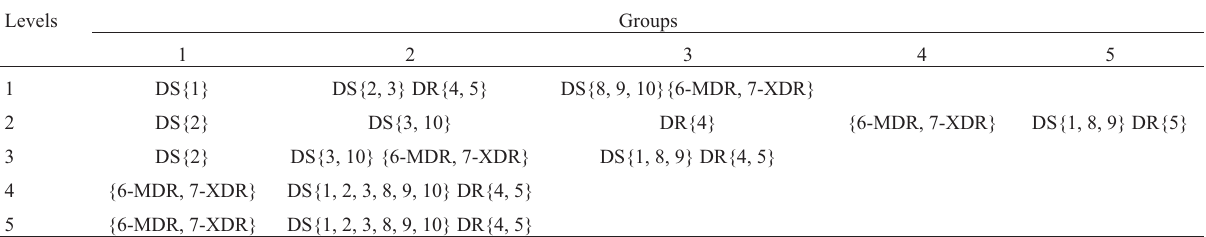
Table 3 - Formation of the groups at each level of decomposition. Levels